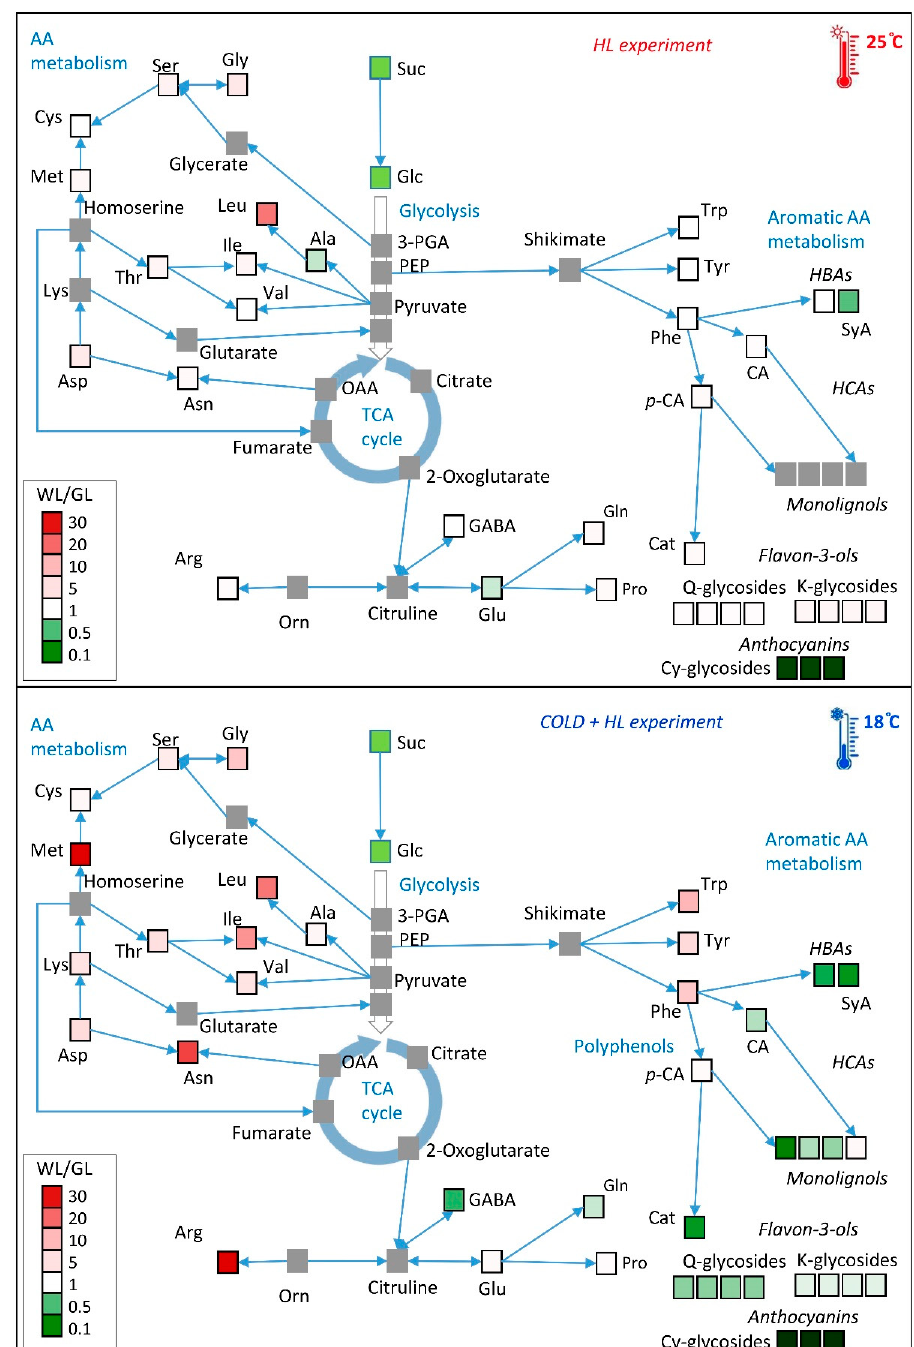
Figure 16. The main metabolic alterations of P. zonale GL and WL in response to treatments with HL and a lower temperature (18 ◦ C). The colours indicate the WL/GL of each identified metabolite after eight days. Important metabolites that were not determined are marked in grey. CA, caffeic acid; Cat, catechin; Cy, cyanidin; GABA, γ -aminobutyric acid; Glc, glucose; HCA, hydroxycinnamic acids; K, kaempferol; OAA, oxaloacetate; p -HBA, p -hydroxybenzoic acid; p -CA, p -coumaric acid; PrcA, protocatechuic acid; Q, quercetin; Rha, rhamnose; Suc, sucrose; SyA, syringic acid; TCA, tricarboxylic acid